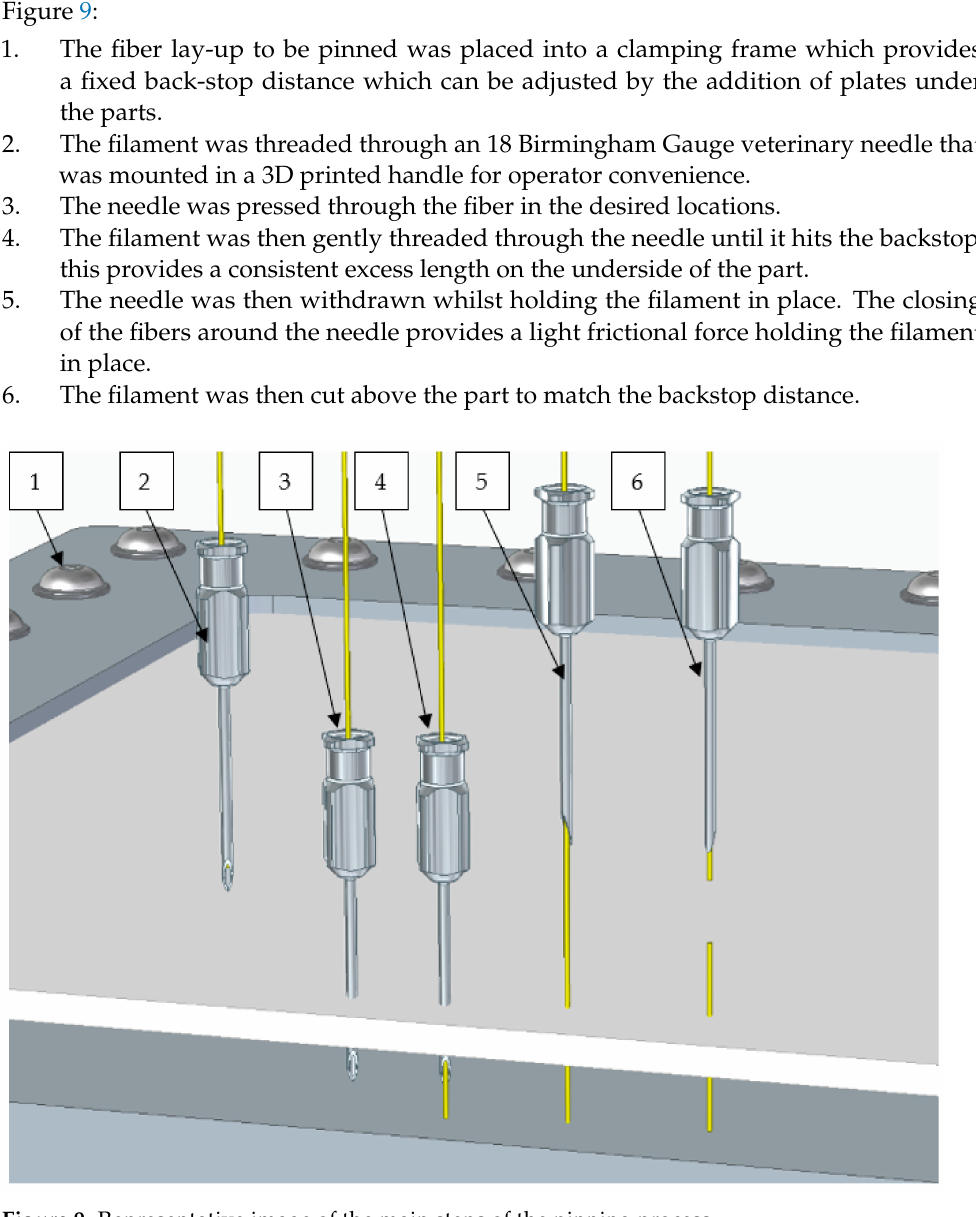
Figure 9. Representative image of the main steps of the pinning